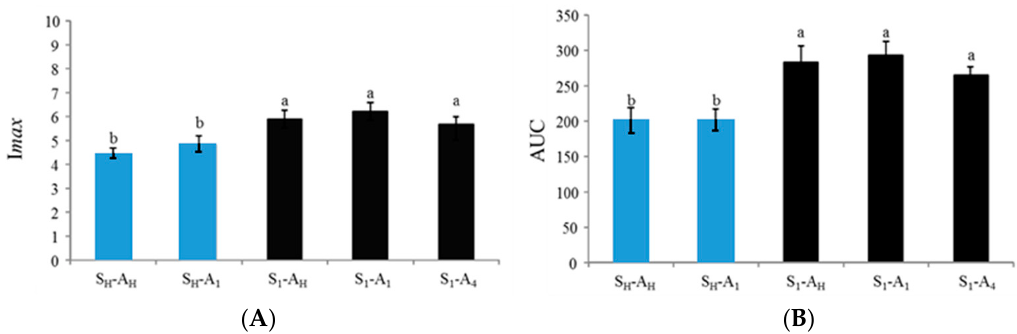
Figure 5. Mean Imax: maximum intensity ( A ) and AUC: area under the curve ( B ) for saltiness measured in FLP products